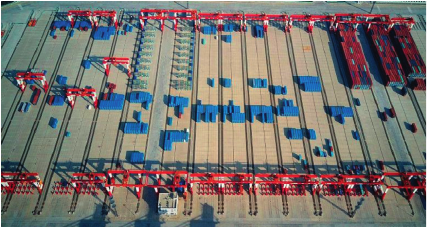
Figure 1: Twin ASC stacking blocks at Yangshan automated container